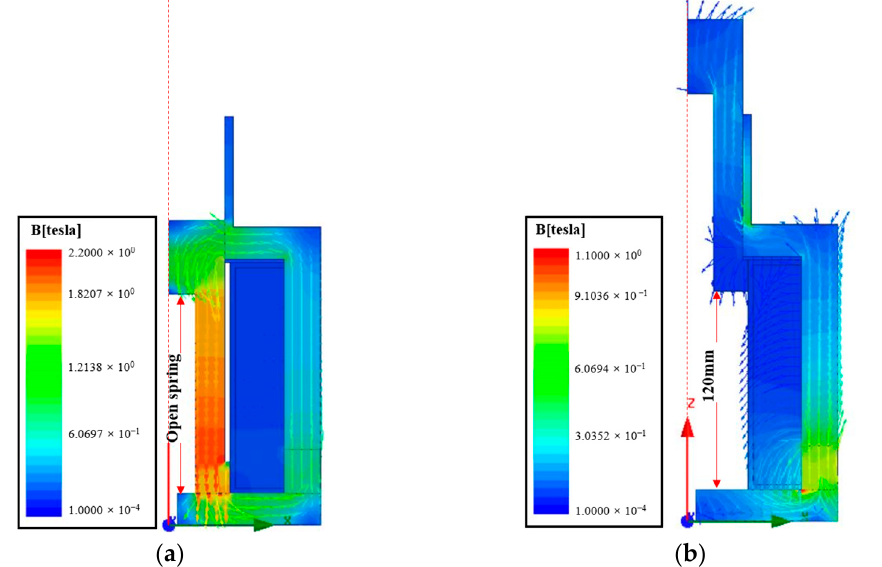
Figure 8. Magnetic flux density and magnetic flux vector of PMA in ( a ) closed and ( b ) open states.